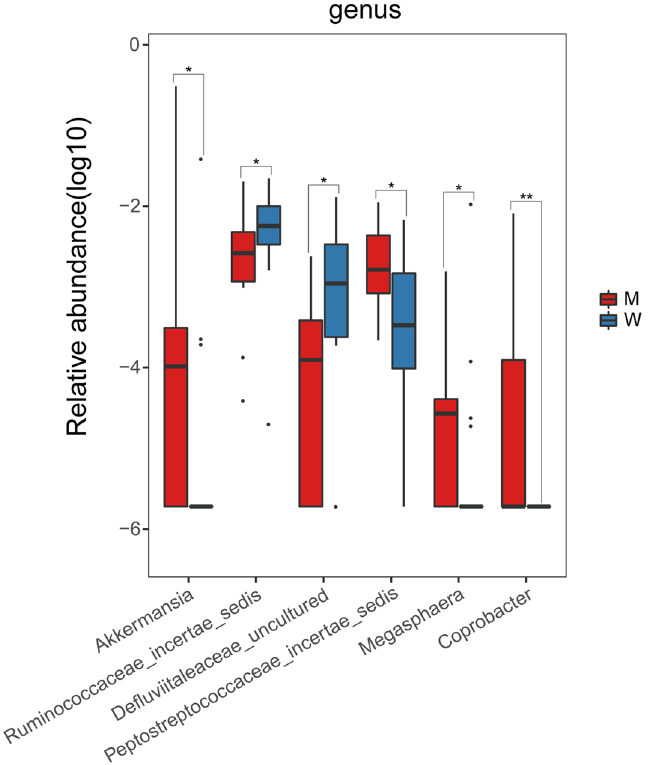
Figure 2. Different abundant bacteria on genus level between the M and W groups of the CAPD patients. W well-nourished group, M malnourished group.